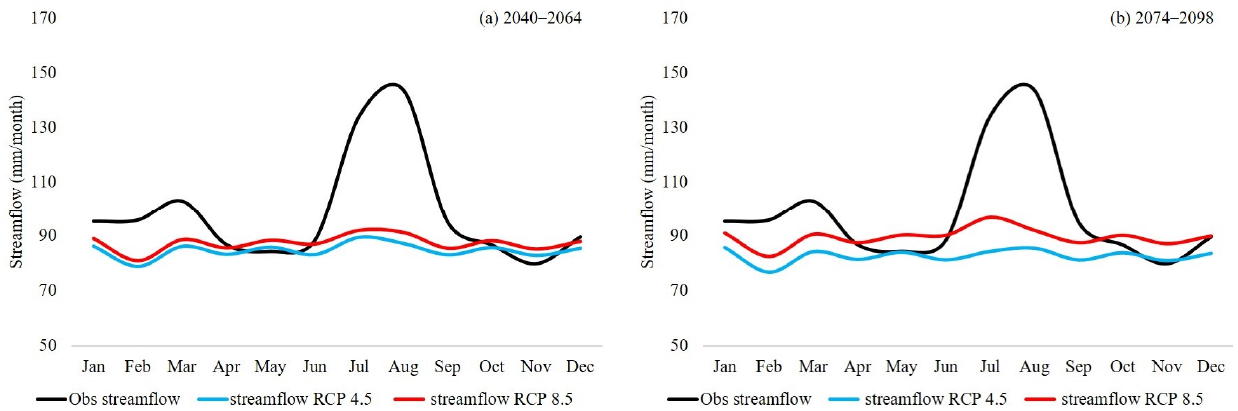
Figure 8. Average monthly streamflow, as projected using the 5 best performing NEX-GDDP models under the RCP 4.5 and 8.5 (blue and red lines, respectively) to force the HBV-light model over Dhoke Pathan sub catchment for ( a ) 2040–2064 and ( b ) 2074–2098. For comparison purposes, the corresponding historical values are also given in black.